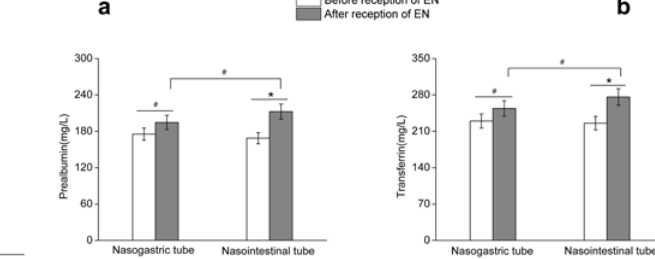
Figure 1: The durations of ICU stay and mechanical ventilation in the nasointestinal tube group were shorter than that in the nasogastric tube group(Fig 1a). The incidence of VAP were significantly lower for the nasointestinal tube group than for the nasogastric tube group (Fig 1b).